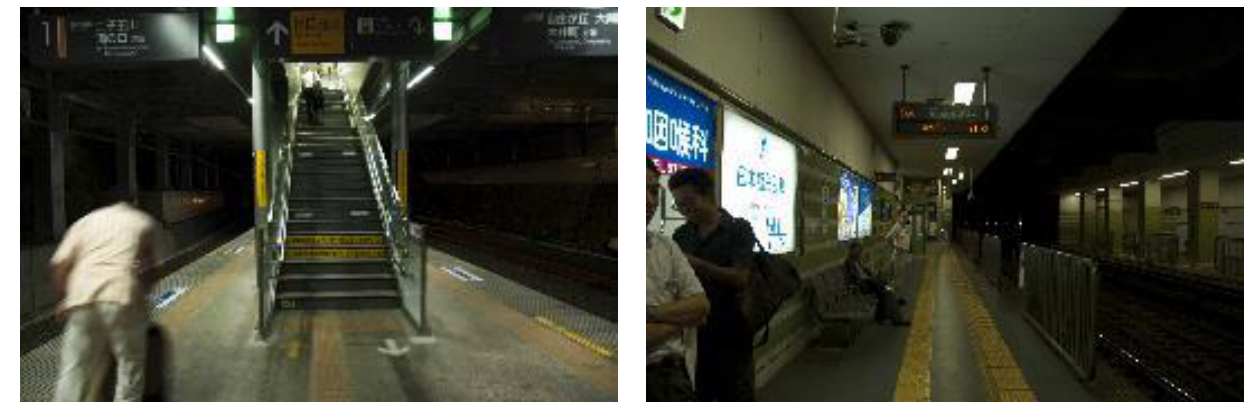
Figure 10. front views of No. 19 ( left ) and No. 21 ( right ). Figure 10. Front views of No. 19 ( left ) and No. 21 ( right ).